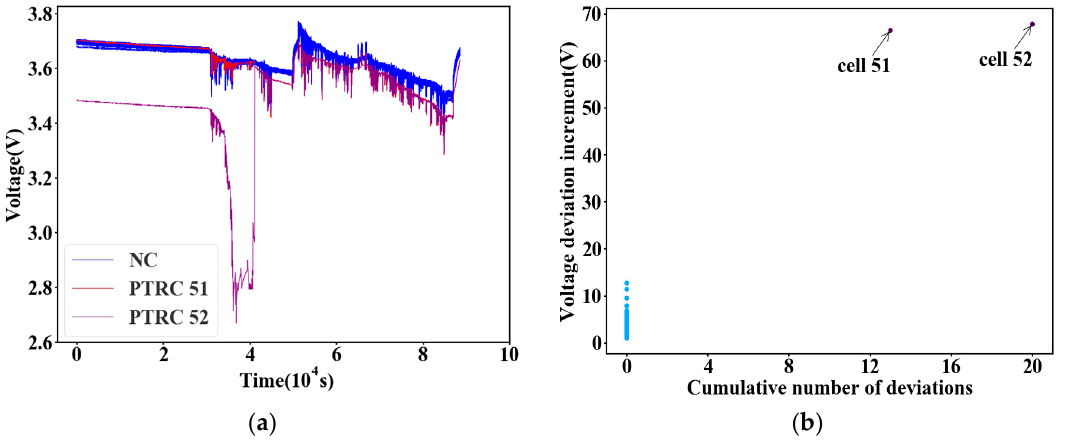
Figure 7. ( a ) The voltage curves of vehicle 2; ( b ) The DBSCAN clustering results of vehicle 2.